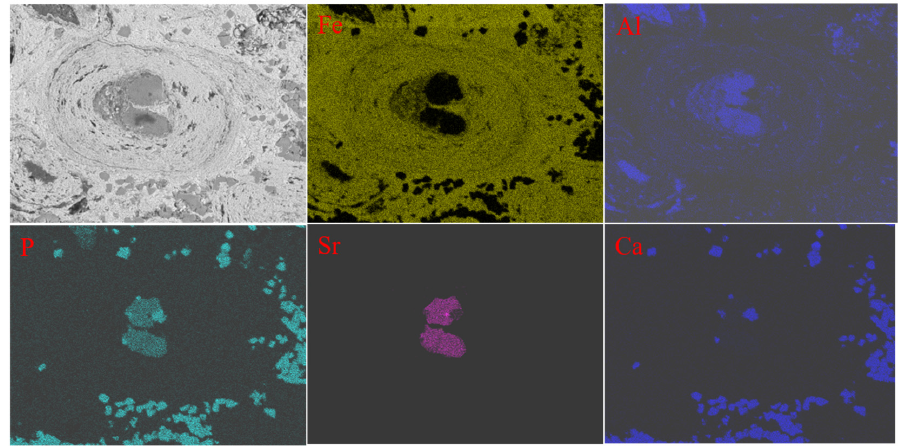
Figure 3. SEM of HPOH ore.